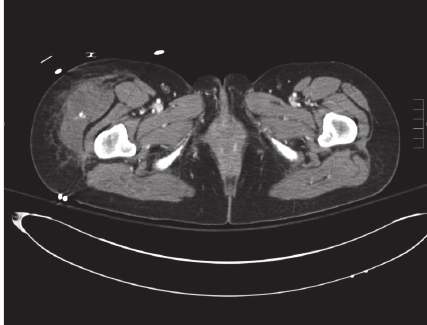
Figure 6: Contrast enhanced CT demonstrates an area of active extravasation and surrounding hematoma.